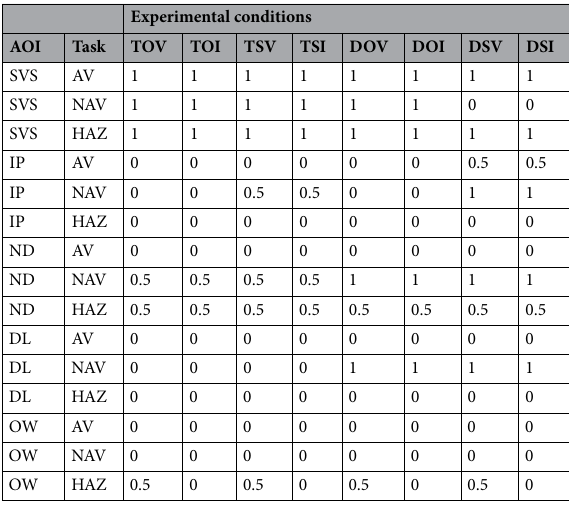
Table 4. Relevance of AOIs to subtasks 32